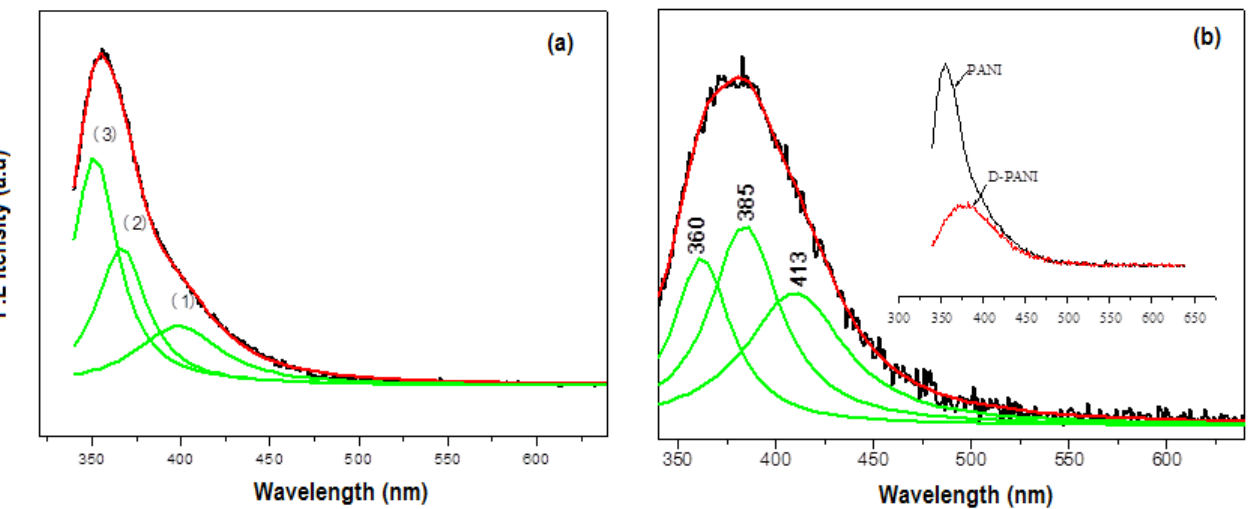
Figure 4. Photoluminescence spectra of pure ( a ) and sulfonic acid-doped ( b ) PANI. Black line: experimental; red line: Gaussian fit; green line: Gaussian components. The inset shows the PL intensity decrease from pure to doped PANI.